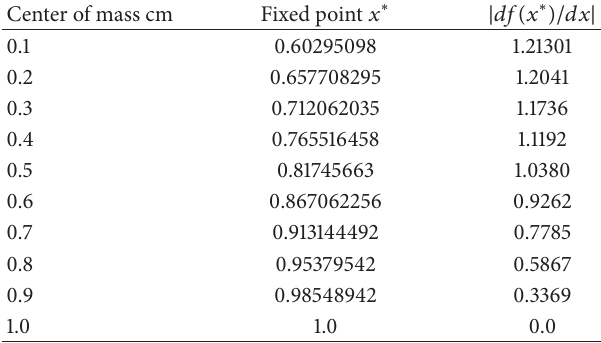
Table 1: Fixed points of period one with 𝜆 = 0.5 and stability deter- mination for different values of